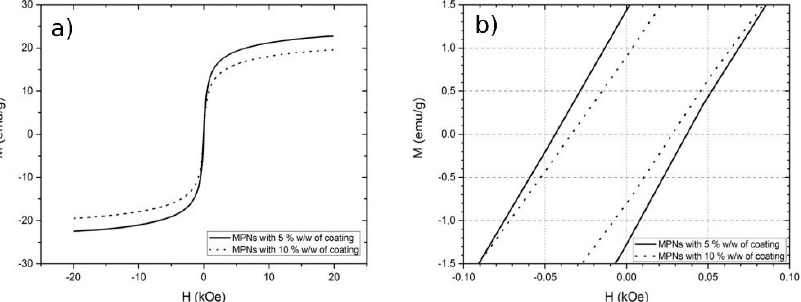
Figure 5. VSM curve of functionalized MA at room temperature. ( a ) Magnetic saturation, ( b ) coerciv- ity